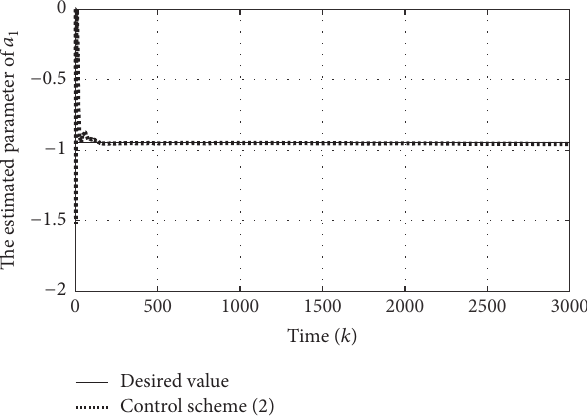
Figure 16: Evolution curve of the estimated parameter ̂𝑎 1 (𝑘) .